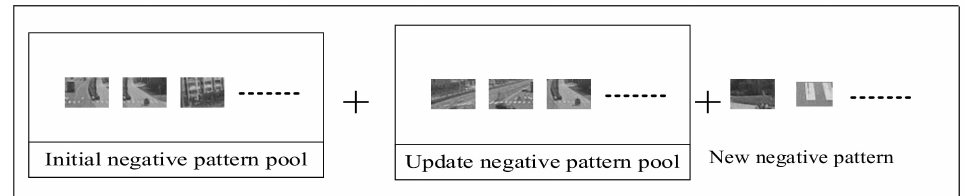
Figure 14. Storing method of the negative pattern